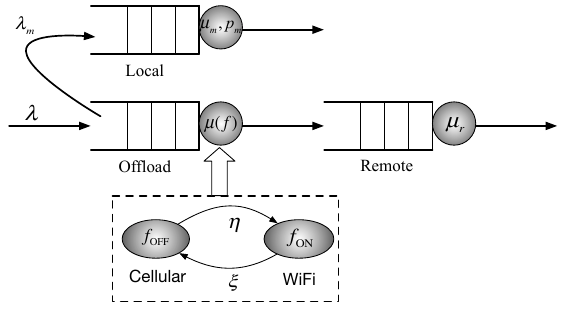
Figure 2: Partial offloading model with cellular and WiFi